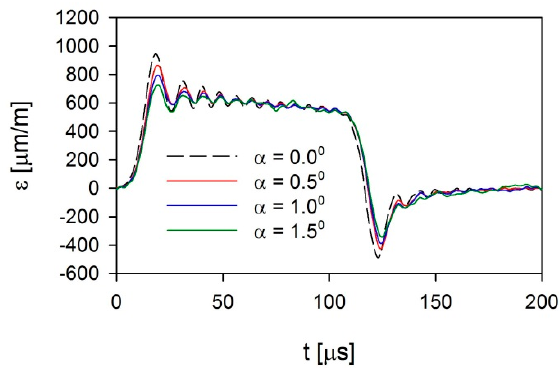
Figure 11. Reflected disturbed pulses for SHPB using a rounded striker for an imperfection in the form of inclination angle α between the striker and input bar.